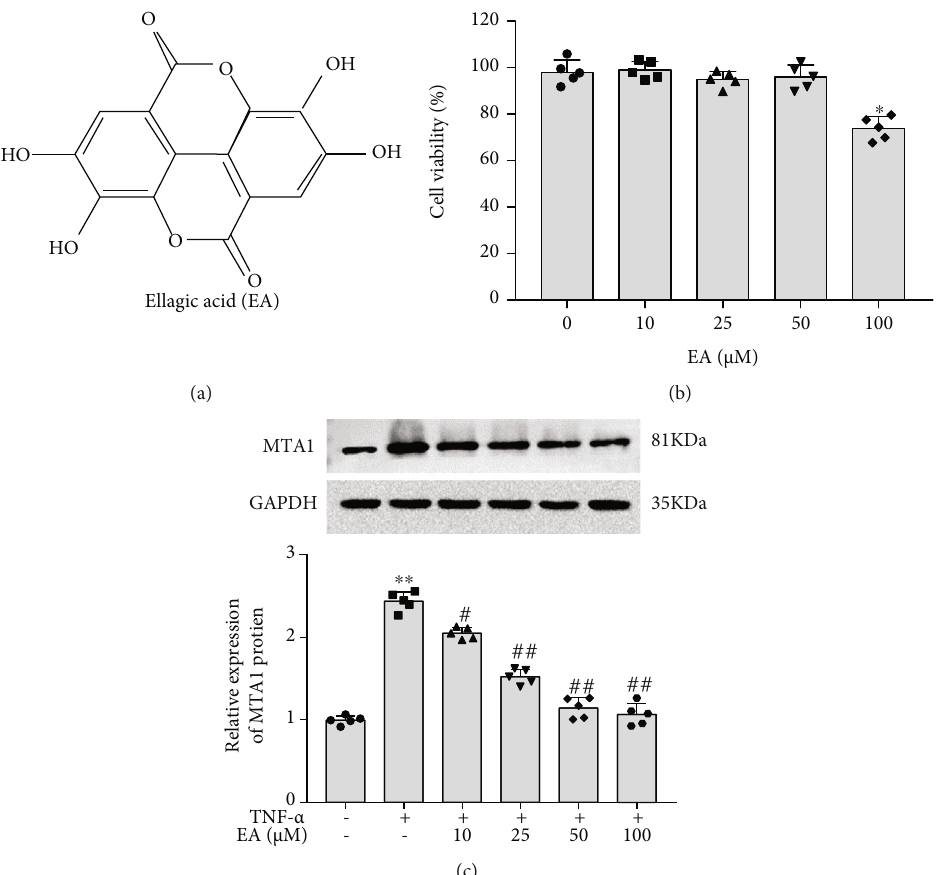
Figure 1: EA reduced MTA1 expression in MH7A cells. (a) The molecular formula of EA. (b) MH7A cells were incubated with di ff erent concentrations (0, 10, 25, 50, and 100 μ M) of EA. MH7A cell viability was measured by using CCK-8 assay. ∗ P < 0 : 05 compared with 0 μ M EA group. (c) MH7A cells were treated with 10 ng/mL TNF- α to induce in fl ammation injury and then incubated with di ff erent concentrations of EA. Western blot analysis was performed to evaluate the expression of MTA1 protein. Data from at least three replicate experiments were presented as mean ± SD . N = 5 . ∗∗ P < 0 : 01 compared with the fi rst group, # P < 0 : 05 , ## P < 0 : 01 compared with the second